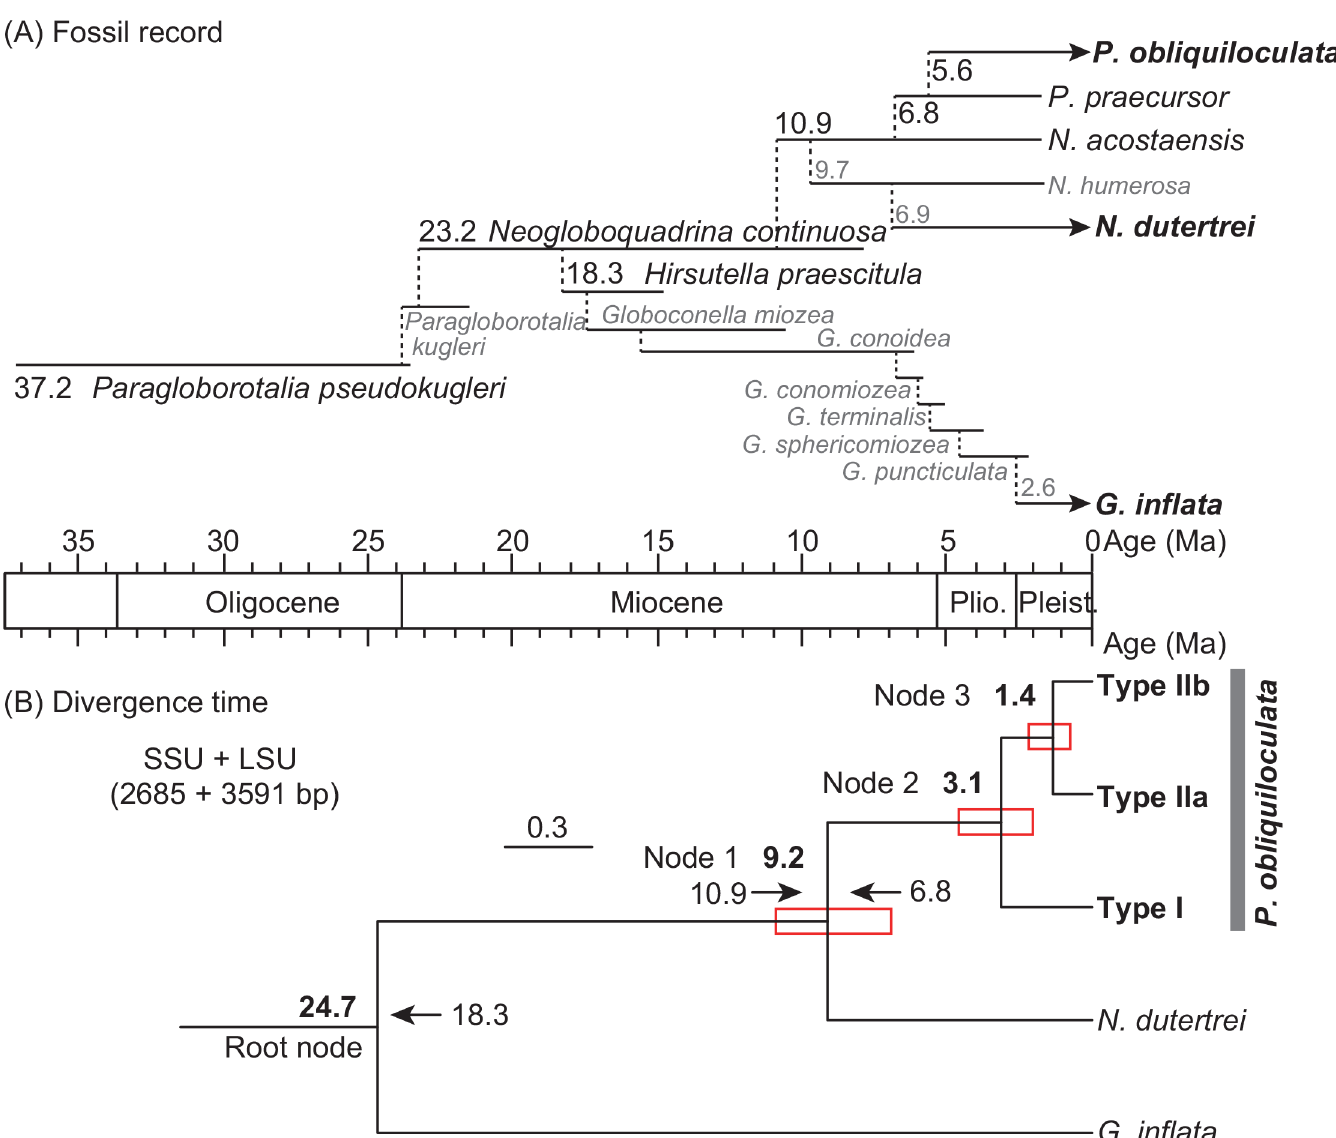
Fig 3. (A) The hypothetical phylogeny of the studied morphospecies and their ancestors following the argument by Aze et al. [23]. Lines show the occurrence of each morphospecies, and the number indicates the FAD of each lineage. The black letters, lines, and numbers are used for the calibration sets shown in Table 2. Arrows indicate the extant species used for the present study. (B) The phylogeny of P . obliquiloculata genetic types with divergence times estimated by using the SSU+LSU dataset with fossil calibration set-4. The posterior mean divergence time (Ma) at each node is shown. The boxes enclosed by red lines indicate the 95%